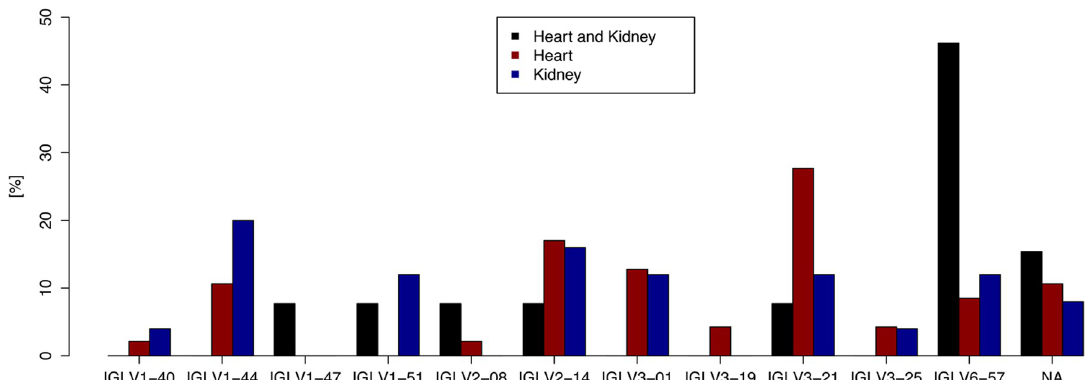
Fig 2. Comparison of the usage of the V λ germline repertoire. Dominant heart and kidney involvement = Heart and Kidney (black), dominant heart involvement = Heart (red), dominant kidney involvement = Kidney (blue). https://doi.org/10.1371/journal.pone.0264407.g002 clone was 78% (SD: 16%), for IGLV2-samples 85% (SD: 10%), for IGLV3-samples 85% (SD: 15%) and for samples of the IGLV6-family 74% (SD: 17%). In nine (11%) cases, no clear assignment could be done to an IGLV-gene or family. These